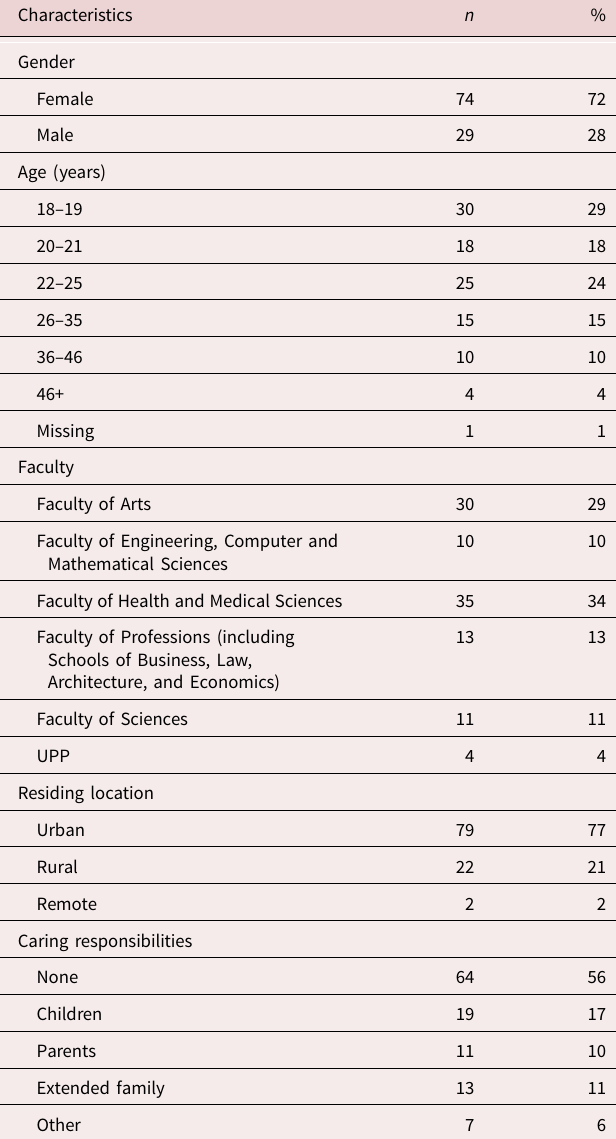
Table 1. Sociodemographic characteristics of participants ( n =103)